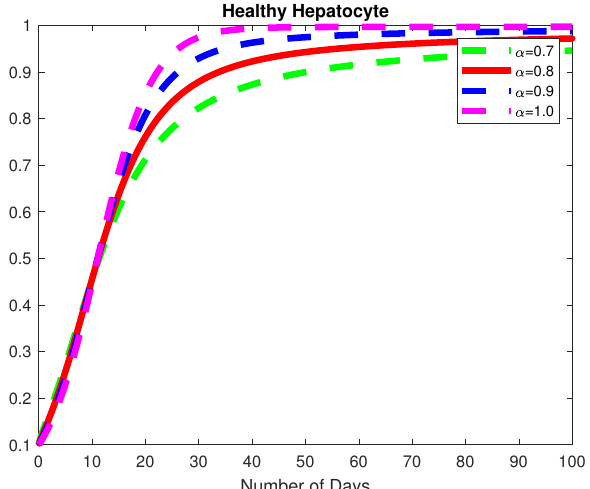
Figure 6. The dynamics of the healthy hepatocytes, H , for varying fractional order α .